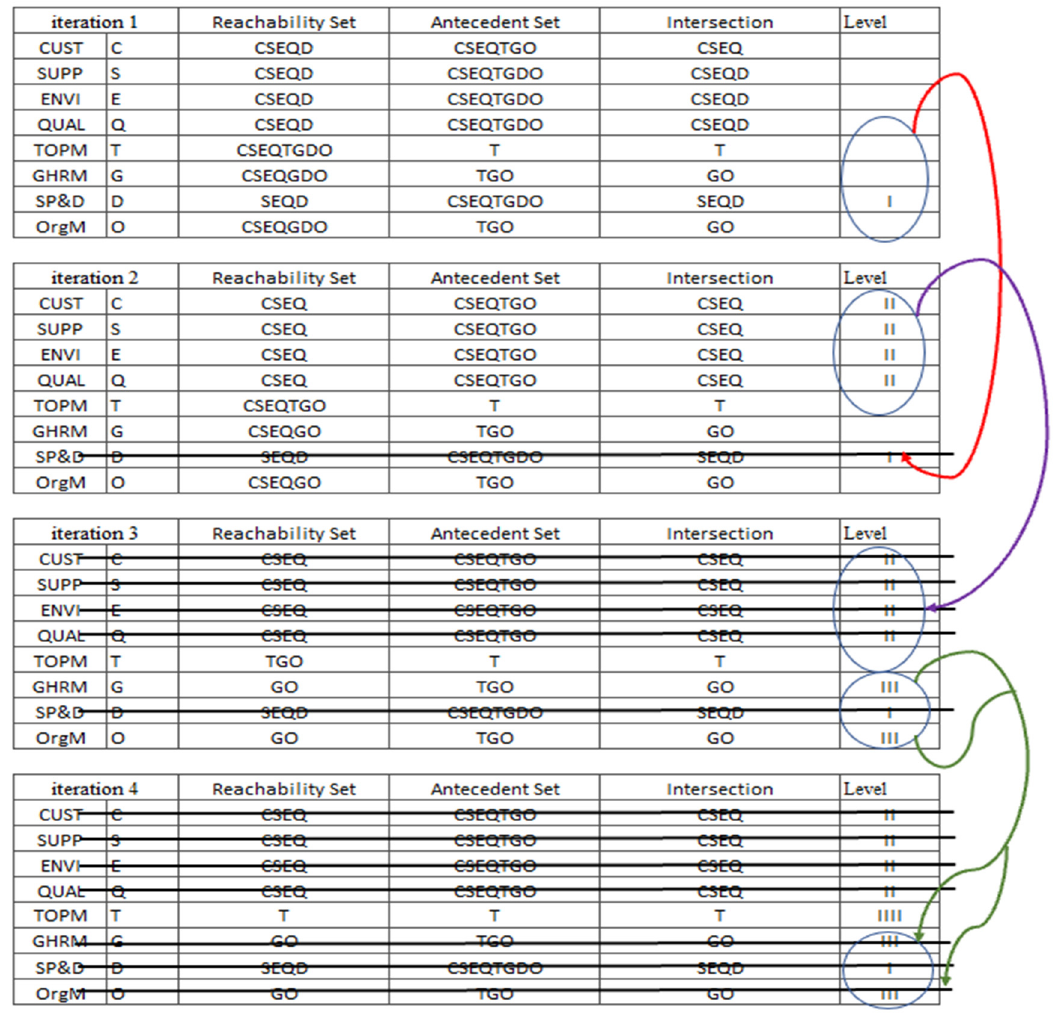
Figure 6. Identification of GSCM practice levels through four sophisticated iterations of interpretive structural modeling (ISM).